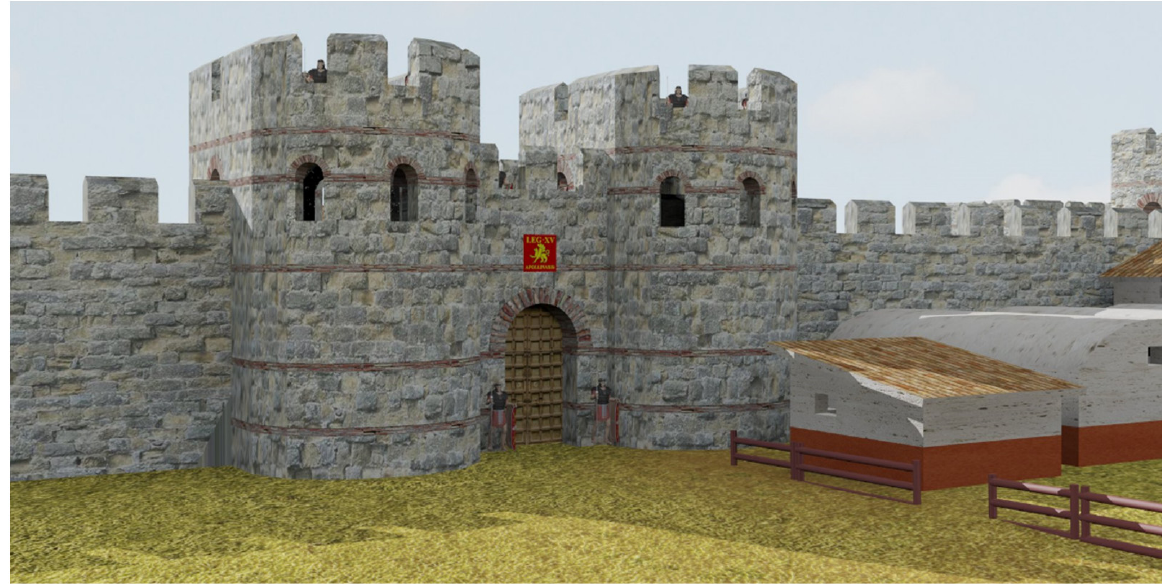
Figure 5. East gate of